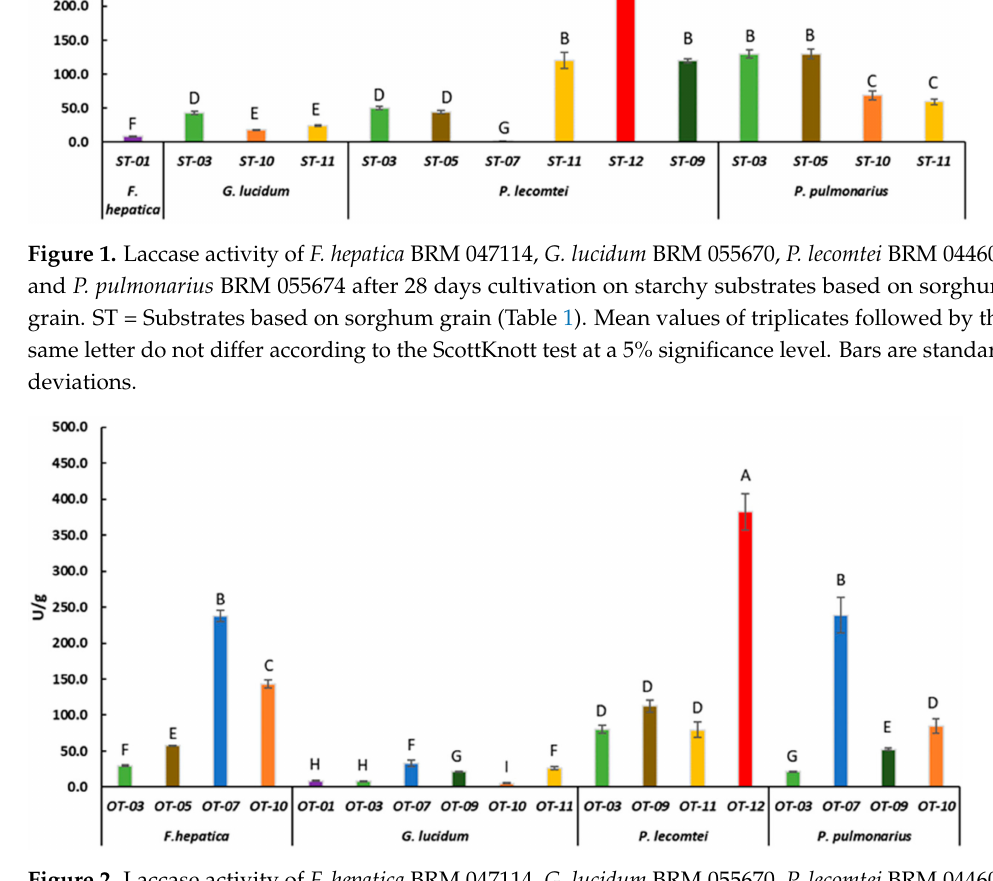
Figure 2. Laccase activity of F. hepatica BRM 047114, G. lucidum BRM 055670, P. lecomtei BRM 044603 and P. pulmonarius BRM 055674 after 28 days cultivation on substrates based on oat grain (starch). OT- Substrates based on oat grain (Table 1). Mean value of experiment performed in triplicate followed by the same letter does not differ according to ScottKnott’s test at the 5% significance